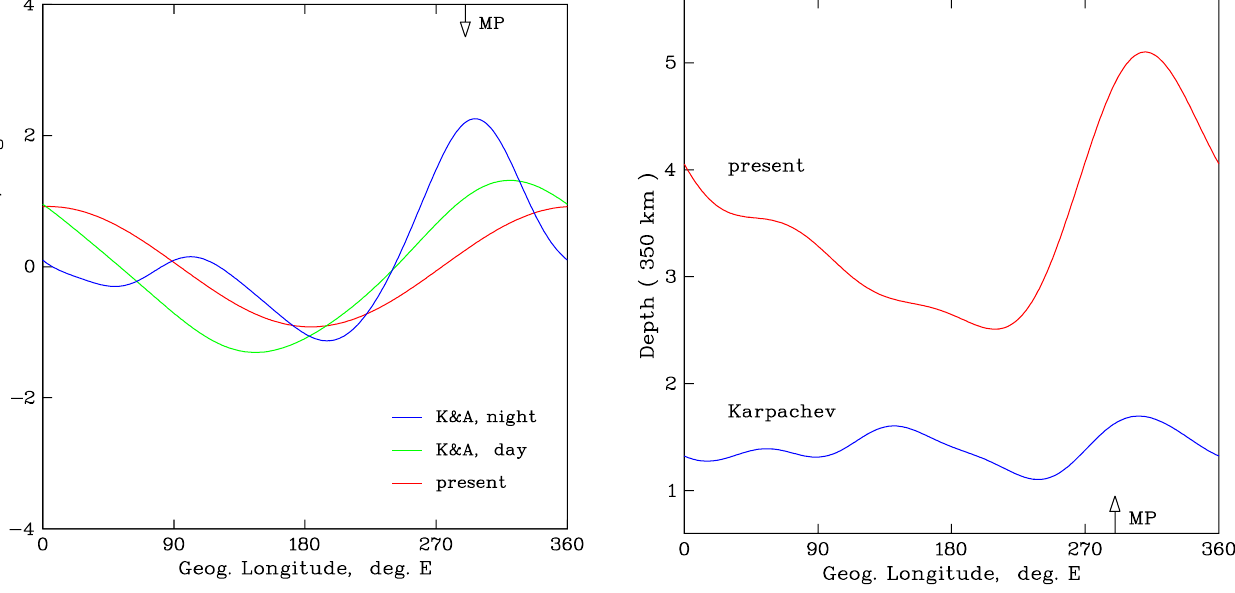
Fig. 16. Longitudinal variation in the magnitude of the density drop in the trough as derived by Karpachev (2003; blue curve) and the present author (red curve). The format of data presentation corre- sponds to that of Fig.